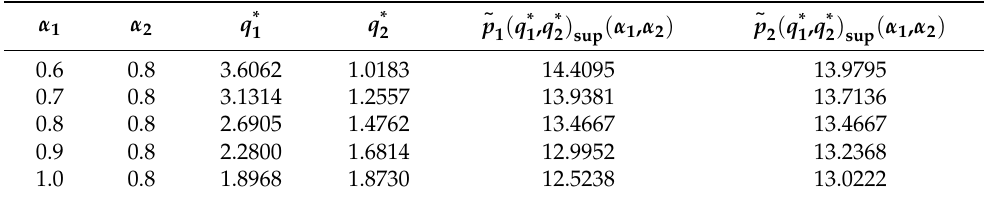
Table 12. ( α 1 , α 2 )-optimistic equilibrium quantity for Scenario IV when CDT ’ s risk aversion levels increase.